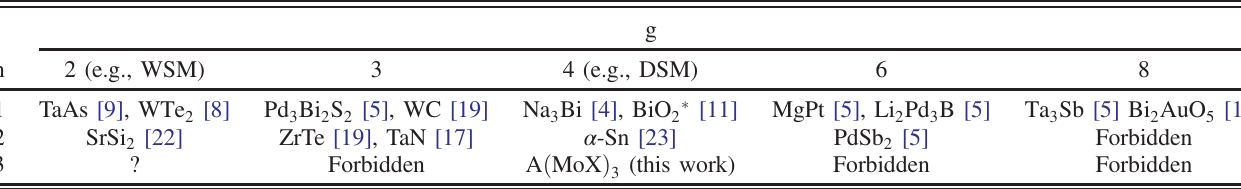
TABLE II. Different types of fermions in solid-state physics with example materials.